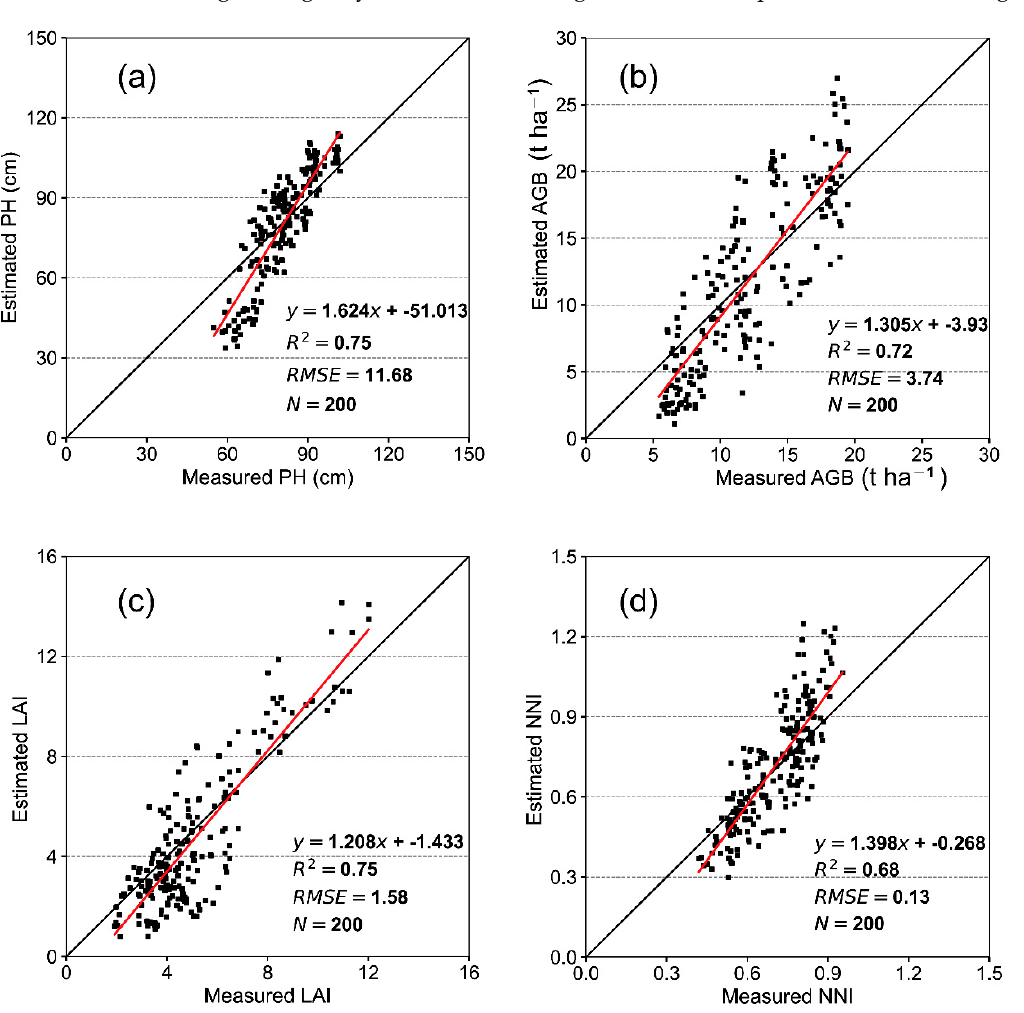
Figure 7. Test plots of measured and estimated values using the established V image–RF model in the full growth stage in 2020. Tests of ( a ) PH; ( b ) LAI; ( c ) AGB; and ( d ) NNI in